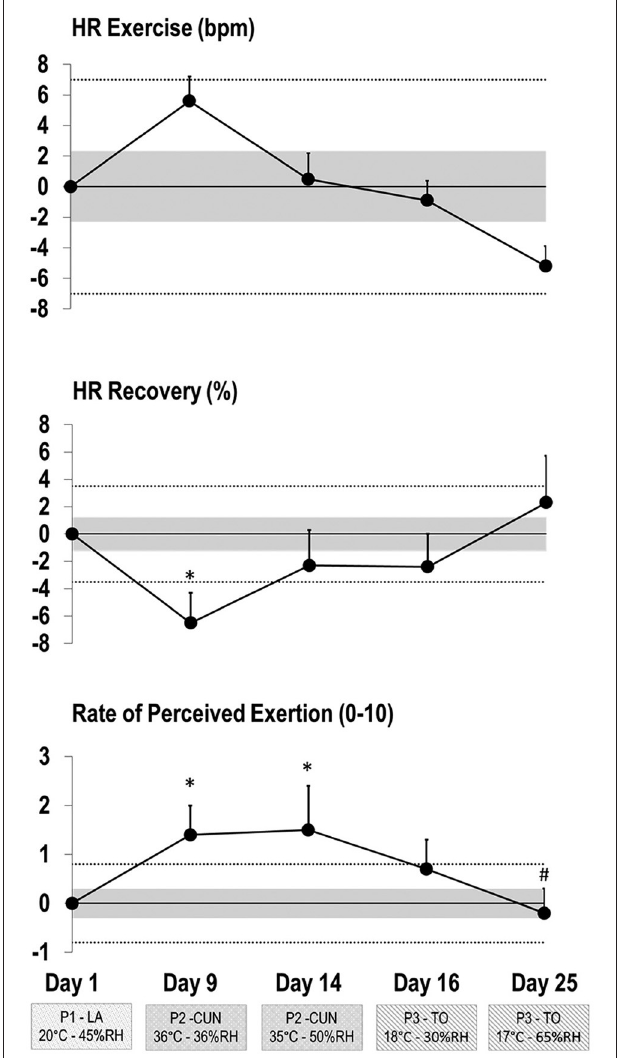
FIGURE 5 | Changes in heart rate (HR) response and rate of perceived exertion (RPE) during the 5 ′ -1 ′ submaximal running test at each time point compared to day 1 in Los Angeles (P1—LA).The shaded area represents trivial changes, and the dash line represents the lower limit for moderate changes [ < 0.20, > 0.60, and > 1.20 of baseline between-subject standard deviation (SD)]. Bars are SDs of changes from baseline to the ensuing testing occasions during phase 2 in Cancun (P2—CUN) and phase 3 in Toronto (P3—TO). *Significant difference from LA ( p < 0.01); # significant difference from CUN 1 and 2.